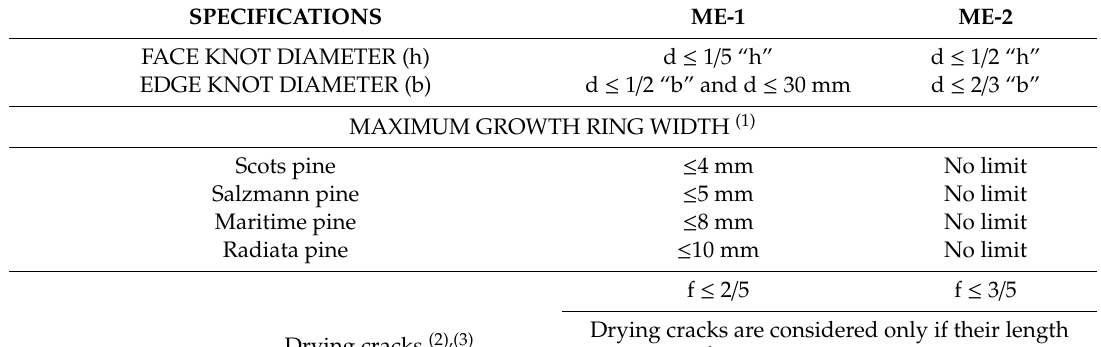
Table 1. Visual grading specifications from Spanish standard UNE 56544 [7] for coniferous sawn timber of a rectangular cross-section and a width b ≤ 70